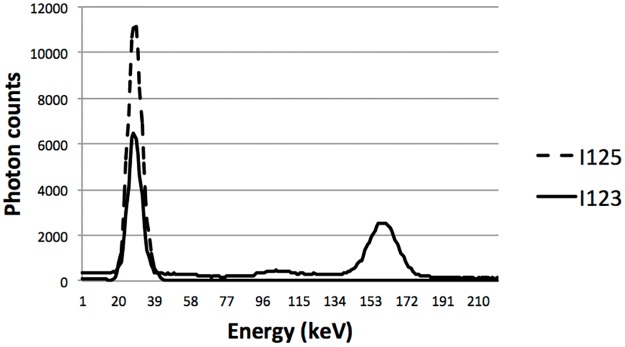
Energy spectra of 123I and 125I for the MGP collimator.